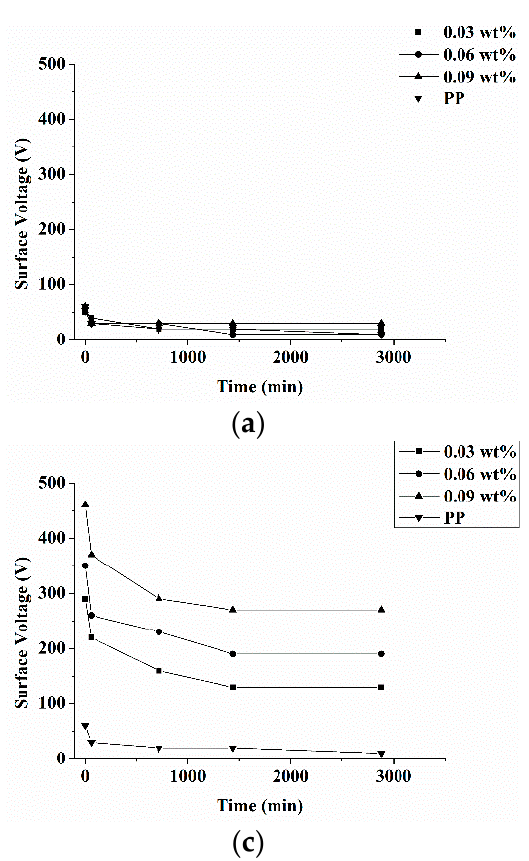
Figure 1. Surface voltage of antibacterial electret PP filters as related to triclosan amount (0.03, 0.06, and 0.09 wt%) and electric field intensity being ( a ) 1.5 kV/cm, ( b ) 2.0 kV/cm, and ( c ) 2.5 kV/cm.